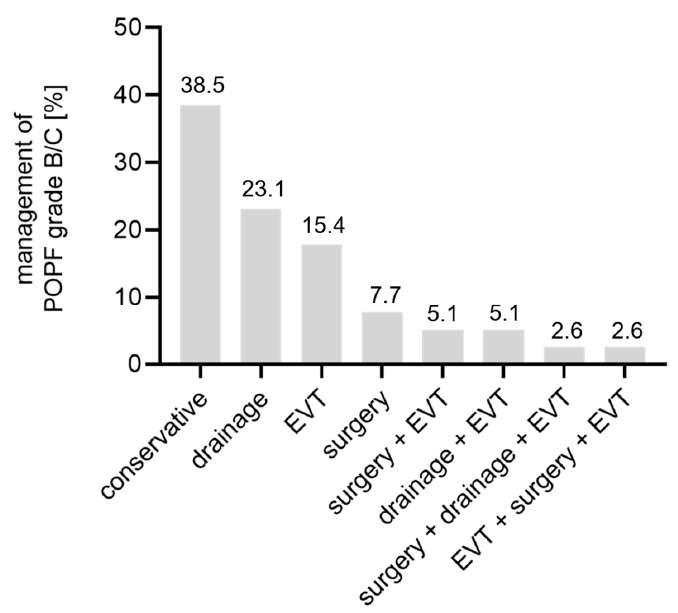
Figure 1. Pancreatic fistula management. EVT = endoscopic vacuum-assisted therapy, POPF = postoper- Figure 1 . Pancreatic fistula management. EVT = endoscopic vacuum-assisted therapy, ative pancreatic POPF = postoperative pancreatic fistula.